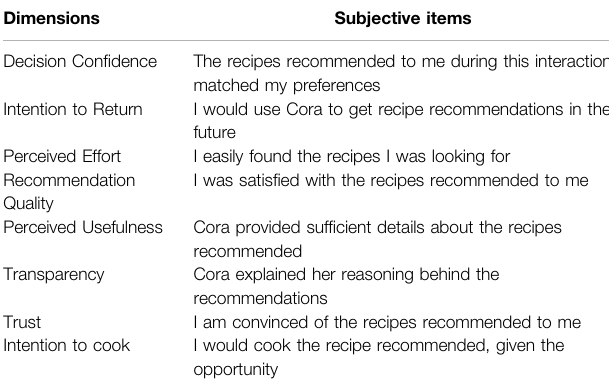
TABLE 5 | Explanations generated depending on the number of recipes recommended and on whether the user ’ s constraints were satis fi ed or not.